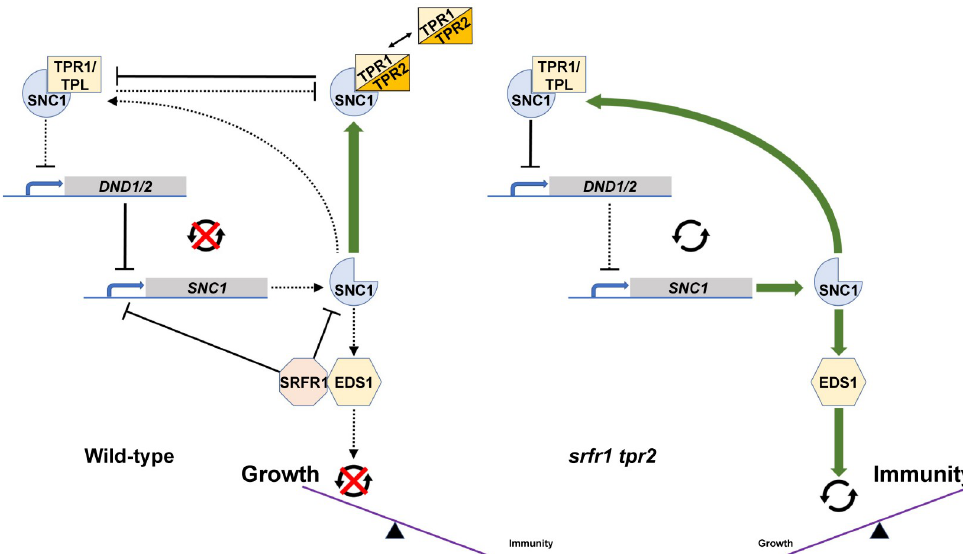
Fig 10. Model for TPR2 and SRFR1 functions in SNC1-mediated autoimmunity. (Left) In Col-0, low levels of SNC1 help to avoid fitness penalties. This may be accomplished both through direct inhibition by SRFR1 and through sequestration by TPR2 of TPR1 to reduce TPR1-SNC1 interactions that affect negative regulators of immunity such as DND1/DND2 and indirectly subsequent SNC1 expression, or through formation of a SNC1-TPR1-TPR2 complex with altered functions compared to an inhibitory SNC1-TPR1 complex. Here, the combined effects of SRFR1 and TPR2 hold SNC1 expression in check. (Right) In the srfr1-4 tpr2-2 double mutant, these molecular check points are released, allowing SNC1 expression to trigger an autoimmune response that results in excessive stunting.